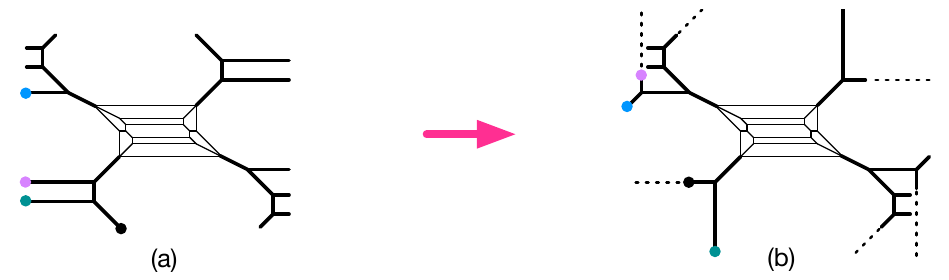
Figure 13 . (a) A 5-brane con(cid:12)guration for SU(6) 0 + 1 TAS + 10 F . (b) SU(6) 0 + 1 TAS + 10 F Tao diagram. Here the thick line means two coincident 5-branes and the dotted lines are the monodromy cuts. 7-brane motions from (a) to (b) are explained in